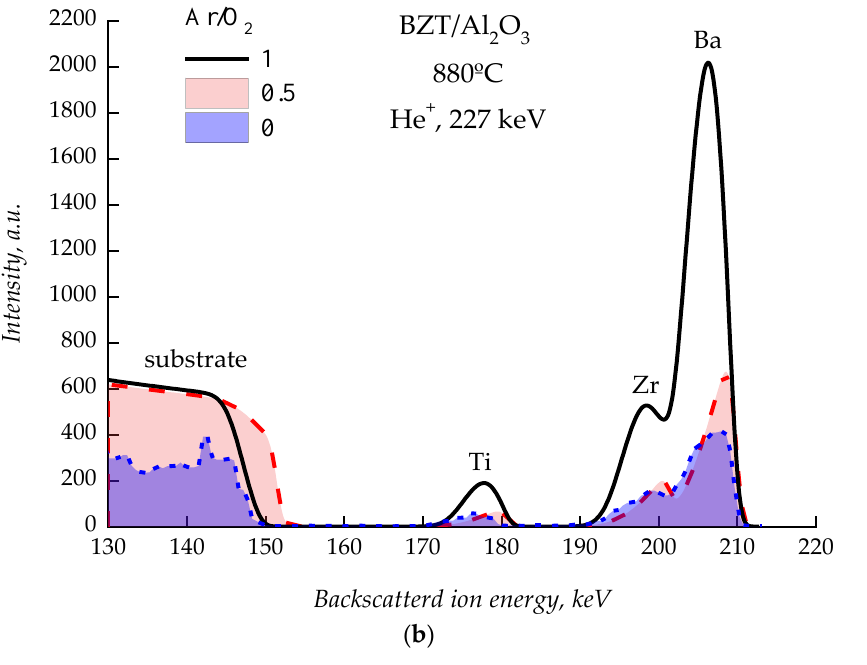
Figure 1. Spectra of backscattered He + ions from BZT island films deposited at different compositions of the working gas at substrate temperatures of 700 ° С ( a ) and 880 ° С ( b ).